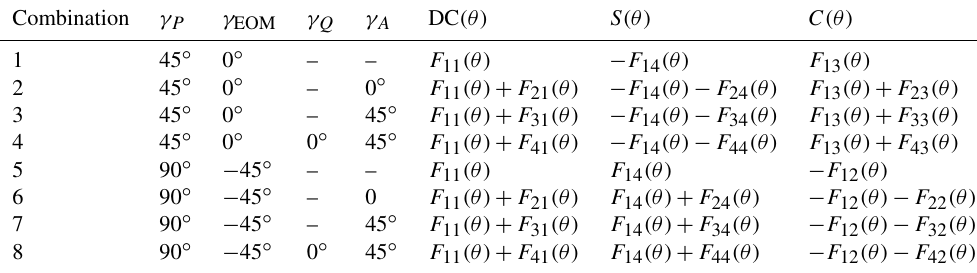
Table 3. Combinations of orientation angles of the optical axes of all the optical elements. Combination γ P γ EOM